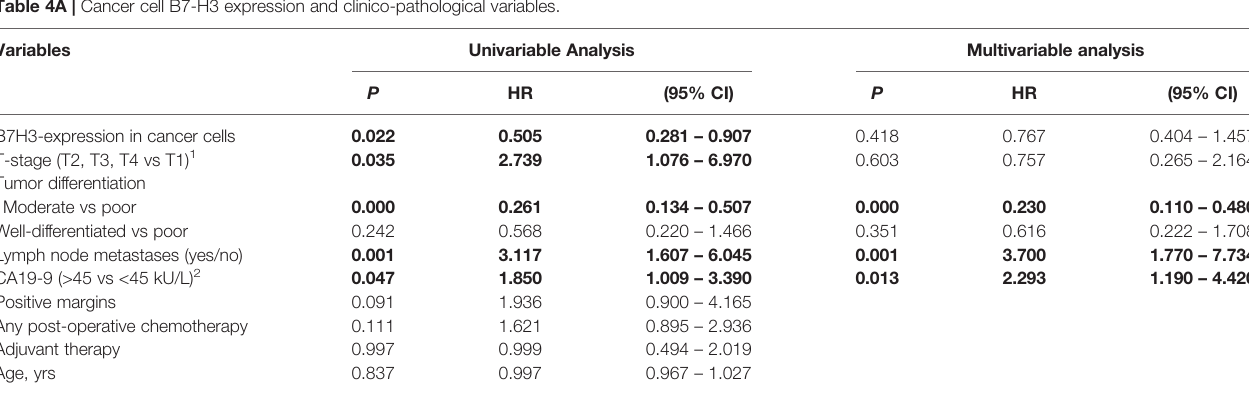
TABLE 4 | Cox proportional hazard regression analysis of time to cancer recurrence in ampullary cancer patients. Table 4A | Cancer cell B7-H3 expression and clinico-pathological variables.